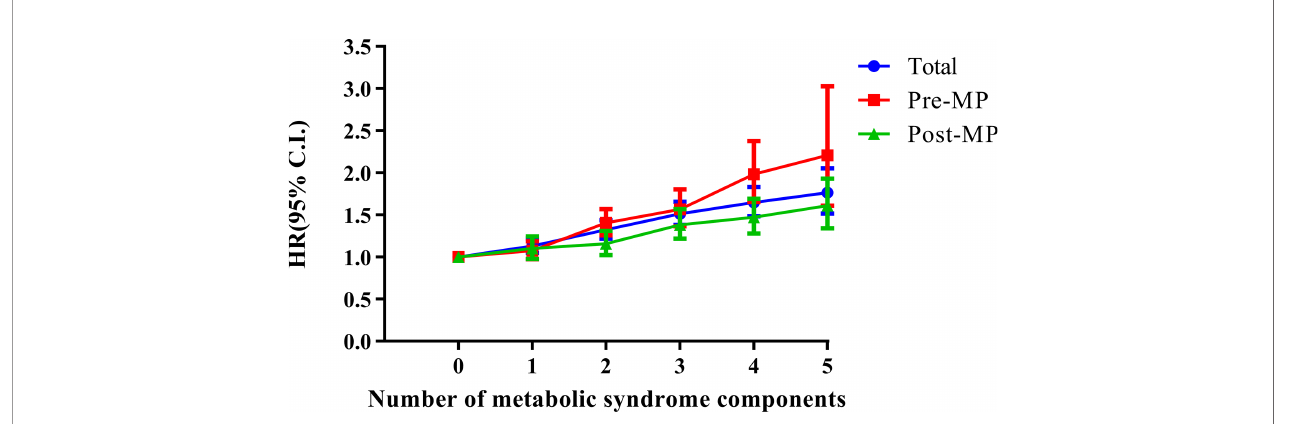
FIGURE 4 | Combined effects of metabolic syndrome and menopausal status on the risk of endometrial cancer. Age, sex, smoking, alcohol consumption, and regular exercise were adjusted. Pre-MP, pre-menopausal; Post-MP, post-menopausal.